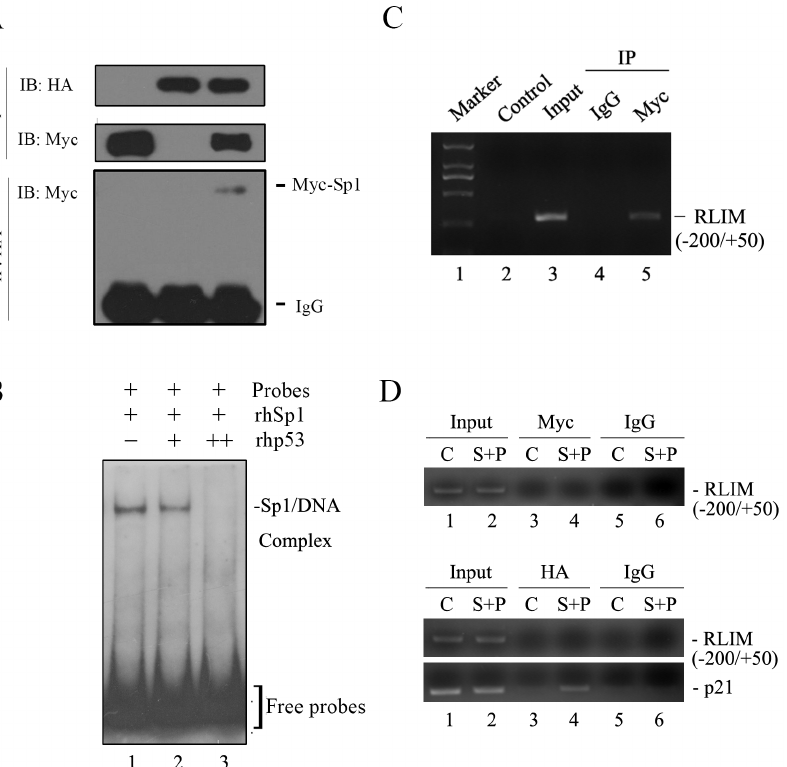
Figure 7. p53 interacts with Sp1 and inhibits its binding to the RLIM promoter. ( A ) H1299 cells were transfected with pCMMV-HA-p53, pCMV-Myc-Sp1 alone or both as indicated. Whole-cell extracts were immunoprecipitated with anti-HA antibody and subjected to Western blot analysis with anti-Myc antibody. As control, 10% of the cell lysates were used as input. ( B ) Effect of p53 on Sp1 binding to the RLIM promoter. Purified recombinant Sp1 and p53 proteins were used for EMSA. The DIG-labeled probe spanning the –100/ + 50 region of the RLIM promoter containing three putative Sp1 binding sites (S2, S3 and S4) was incubated in binding reactions with either rhSp1 protein alone (Lane1) or together with increasing amounts of p53 protein (Lanes 2 and Lane 3). EMSA was performed as described above. Bands for the Sp1-DNA complex and free probes are indicated. ( C ) ChIP analysis for the binding of Sp1 to the RLIM promoter. Chromatin immunoprecipitations (ChIP) were performed with antibodies against either IgG as control or Myc. DNA recovered from immunocomplexes were subjected to PCR using primers flanking Sp1 binding region. ( D ) p53 prevents the binding of Sp1 to the RLIM promoter in vivo . The H1299 cells transfected with either control vector plasmid (C, lanes 1, 3 and 5) or pCMV-Myc-Sp1 together with pCMV-HA-p53 plasmids (S + P, lanes 2, 4 and 6) were subjected to ChIP assays using anti-Myc, anti-HA or IgG antibodies as indicated. DNA purified from input chromatin (Input) or immunocomplexes were subjected to PCR analysis using primers flanking the –200/ + 50 region of the RLIM promoter or p21 promoter as a positive